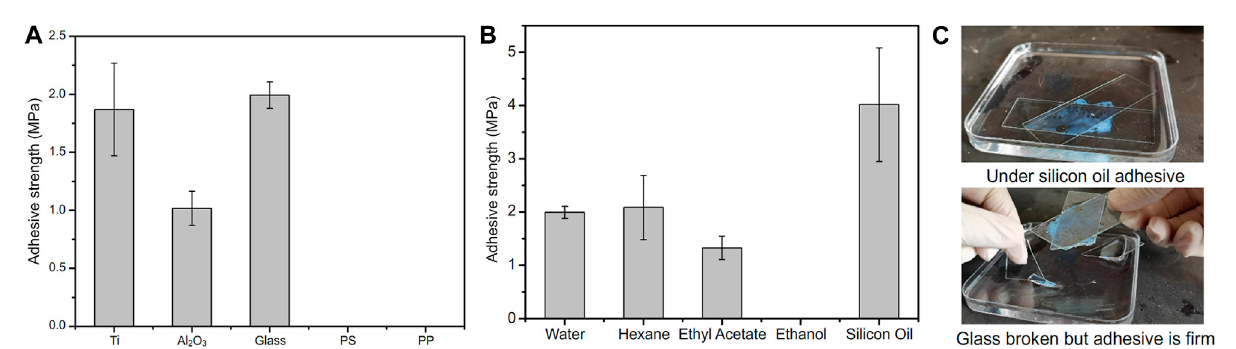
FIGURE 8 AdhesionperformanceofPMAA/PEIadhesiveinwaterandorganicsolvent. (A) PMAA/PEIadhesivecan fi rmlyadheretitanium,aluminumoxide,glass and other polar materials under water, but shows almost no adhesion strength to non-polar materials such as PS and PP; (B) PMAA/PEI adhesive can achieve high strength adhesion to glass in a variety of organic solvents, such as n-hexane, ethyl acetate and siliconeoil, but it cannot achieve adhesion in ethanol. The strength of adhesion glass under silicone oil is even higher than that under water; (C) The adhesion process of PMAA/PEI adhesive to glass under silicone oil. After the polymerization of PMAA/PEI adhesive, the PMAA/PEI adhesive cannot be damaged even when the glass is damaged under the action of tangential